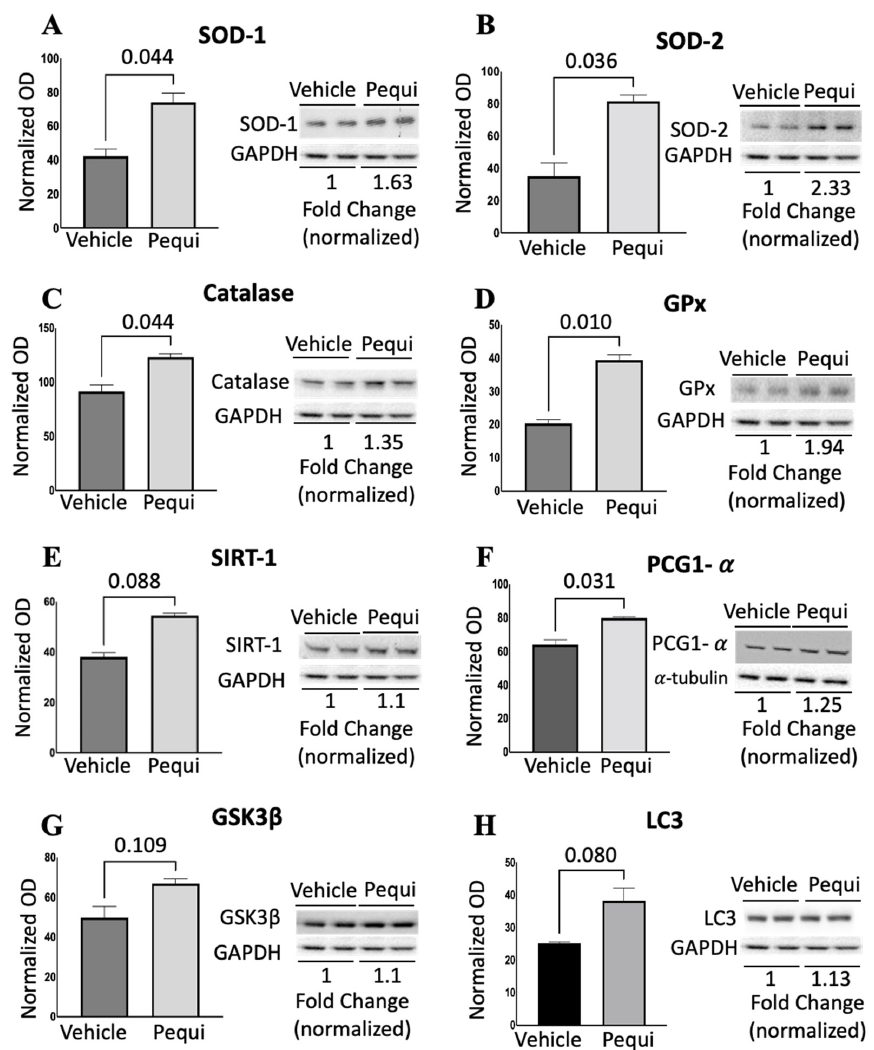
Figure 6. Pequi extract increases expression of antioxidant enzymes in HCAEC. Cells were cultured, pre-treated with pequi extract (25 μ g/mL) for 24 h under normoxia conditions, and total protein content was extracted for Western blots analysis for Superoxide dismutase (SOD)-1 ( A ), SOD-2 ( B ), catalase ( C ), glutathione peroxidase—GPx ( D ), sirtuin 1—SIRT-1 ( E ), peroxisome-proliferator-activated receptor gamma coactivator 1-alpha (PCG1- 𝛼) ( F ), glycogen synthase kinase 3 beta (GSK3 β ) ( G ), and microtubule-associated protein 1A/1B-light chain 3 (LC3) ( H ). Western blots were normalized using 𝛼 -tubulin or glyceraldehyde 3-phosphate dehydrogenase (GAPDH) as loading control. Five independent Western blot experiments were carried for each condition. Representative images are shown here. Statistical analysis was performed using Student’s t -test ( p < 0.05). OD: Optical Density.